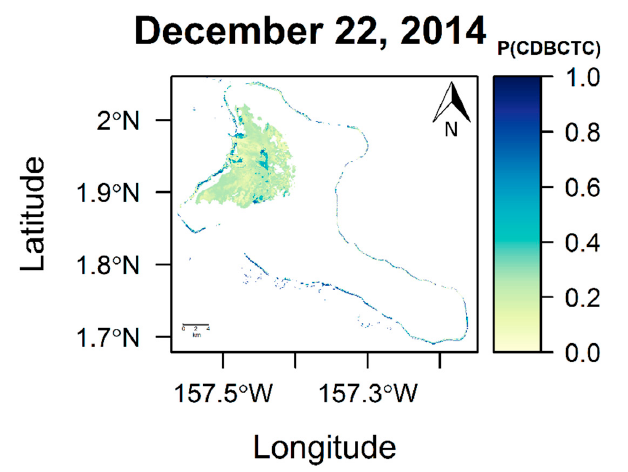
Figure 15. Posterior probability map for the Kiritimati Island area of interest (left, 2002 and right, 2014).